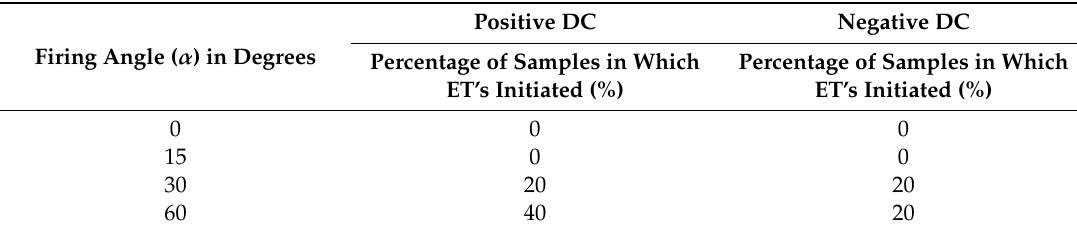
Table 2. Tree initiation at direct current (DC) with ripple voltages.